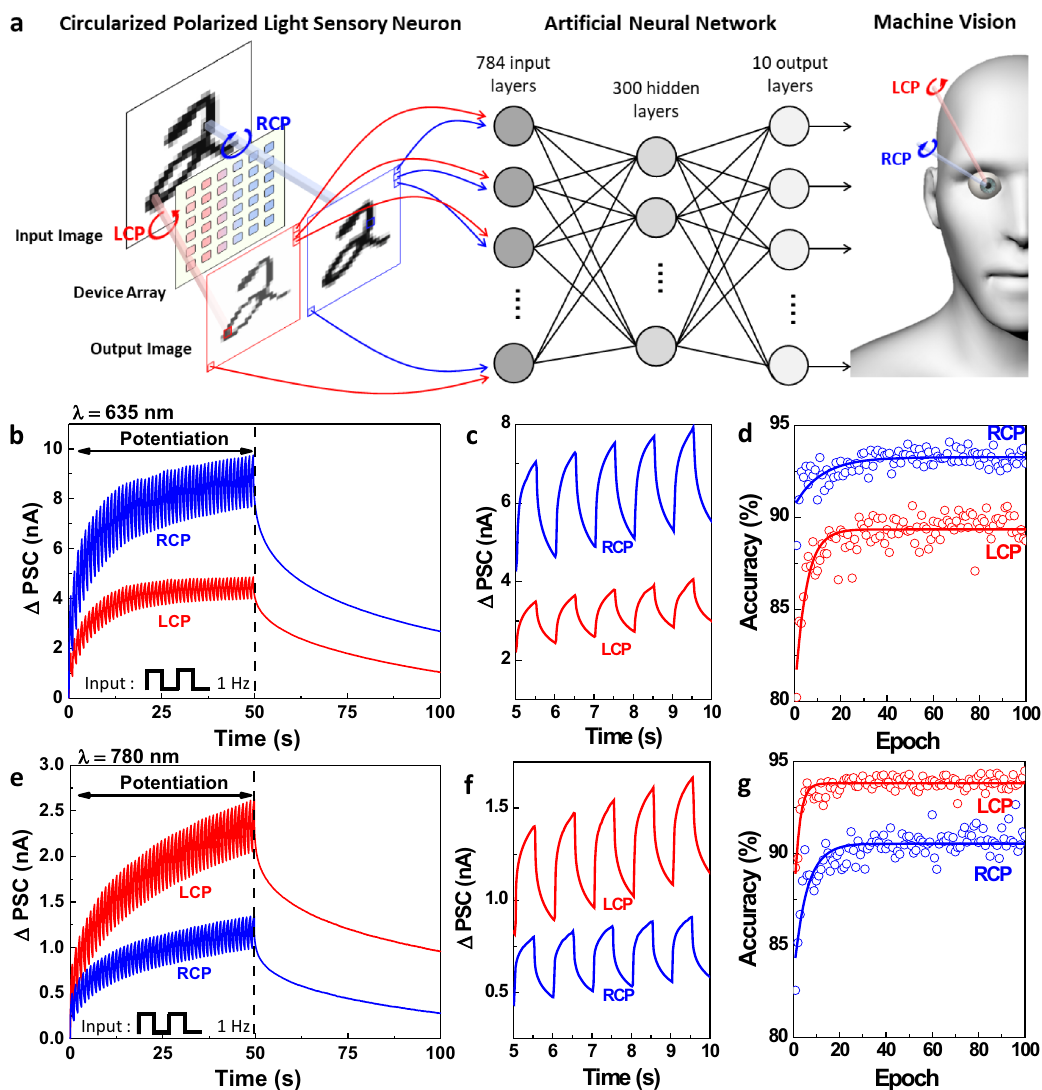
Fig. 7 | Polarization Dependent Image Classi fi cation. a Arti fi cial neural network structure based on circularly polarized light sensory neuron to perform hand- written digit classi fi cation work using the MNIST database, and schematic of machine vision featuring differences in learning ef fi ciency depending on the cir- cularpolarizationstate. b Potentiationcurveunder1HzCPLpulseilluminationata 635nmwavelength,anddecayingcurvewithoutlightillumination.Theintensityof CPLwas setto 4.9mW( c ),Magni fi ed postsynapticcurrent between5.0and10.0s,